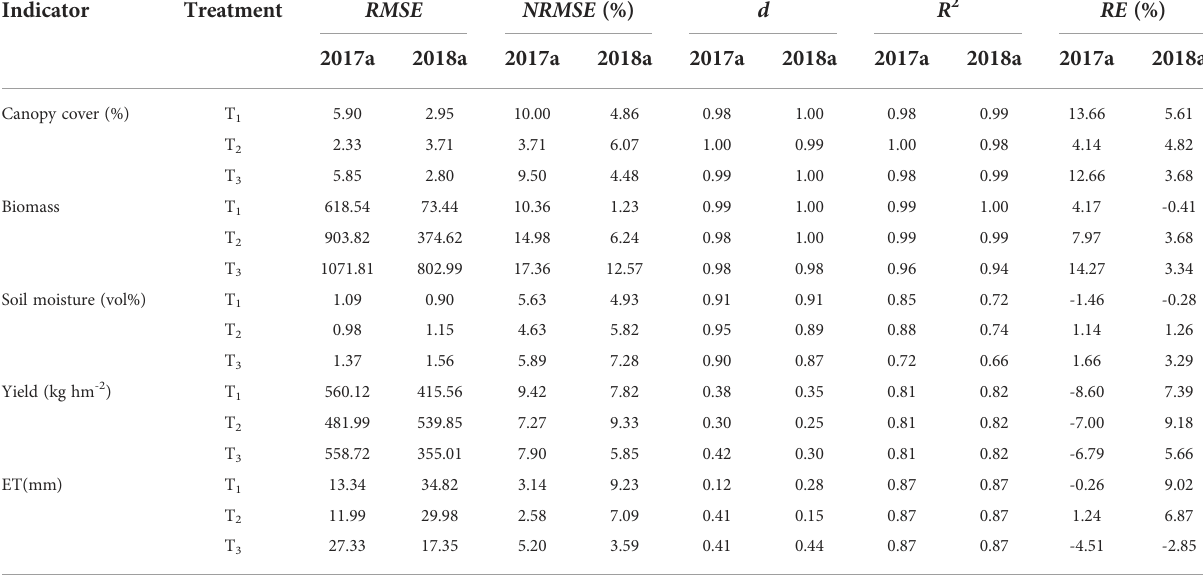
TABLE 5 Calibration and validation of AquaCrop model.